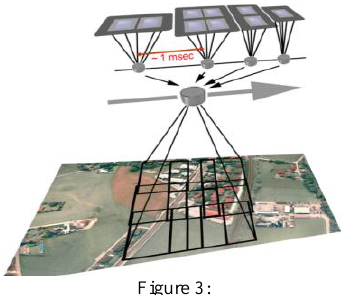
Figure 3: Illustrating “syntopic” imaging. The individual 4 optical cones “fire” one Figure 1: after the other at intervals in time that correspond with the movement of The core idea of the UltraCam-technology is the assembly of one large the camera platform. In a typical aerial mission, a millisecond will aerial image from 9 separate tiles imaged through 4 separate optical cones represent the airplane’s move forward by ~ 7 numbered 1 through 4 [at right]. At left is a view of the 4 linearly arranged optical cones for the high resolution panchromatic image segments and the 4 additional optical cones for the lower resolution color channels. The resulting large format image has 5 bands with pan-infrared- red-green-blue. The pixel numbers at right concern the UltraCam-Xp model with 17.3K x 11.3K.